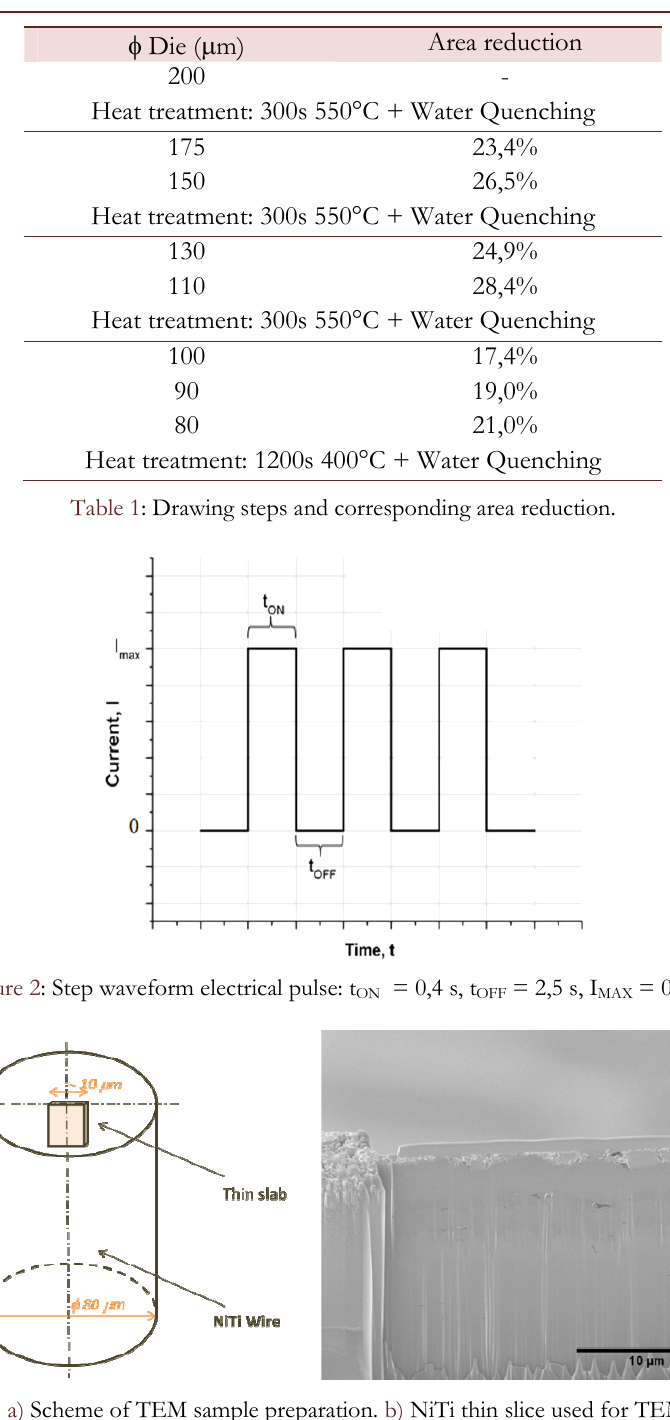
Figure 3: a) Scheme of TEM sample preparation. b) NiTi thin slice used for TEM